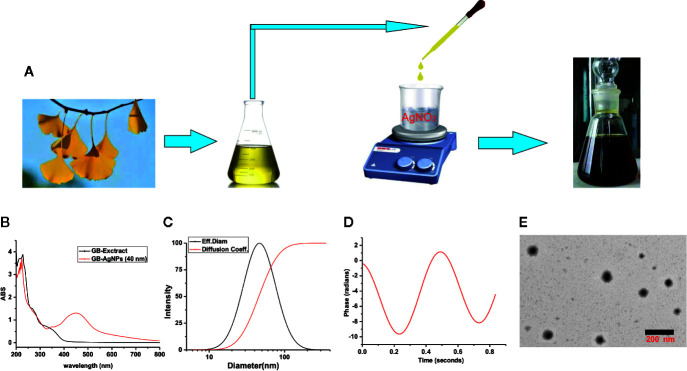
Schematic representation of silver nanoparticle synthesis with aqueous extracts of G.biloba leaves. (A) Step silver nanoparticle (AgNP) synthesis; (B) UVspectrum; (C) dynamic lights scattering (DLS) images; (D) Zeta-potential images; and (E) TEM images.